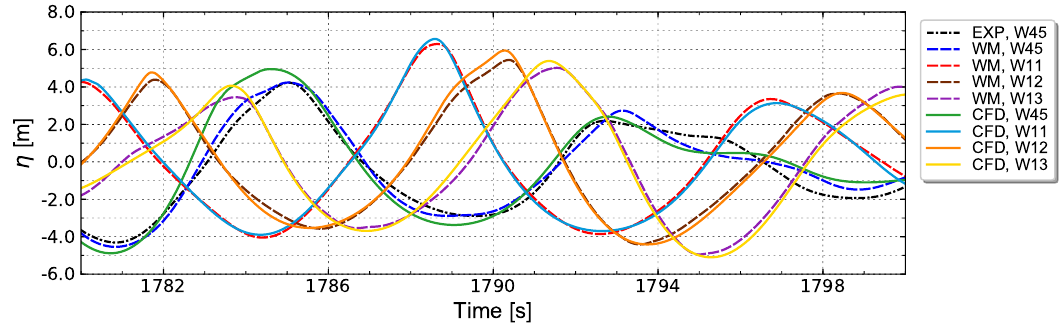
Figure 4. The best realised reconstructed undisturbed wave compared to the measured undisturbed wave, where ’WM’ indicates the waves measured during the undisturbed wave experiments at probes W45, W11, W12 and W13, ’CFD’ the undisturbed numerical reconstructions at the same locations and ’Exp’ the wave measured during the experiment with the model at probe W45 (for reference). Figure based on the same data as a figure in [44].